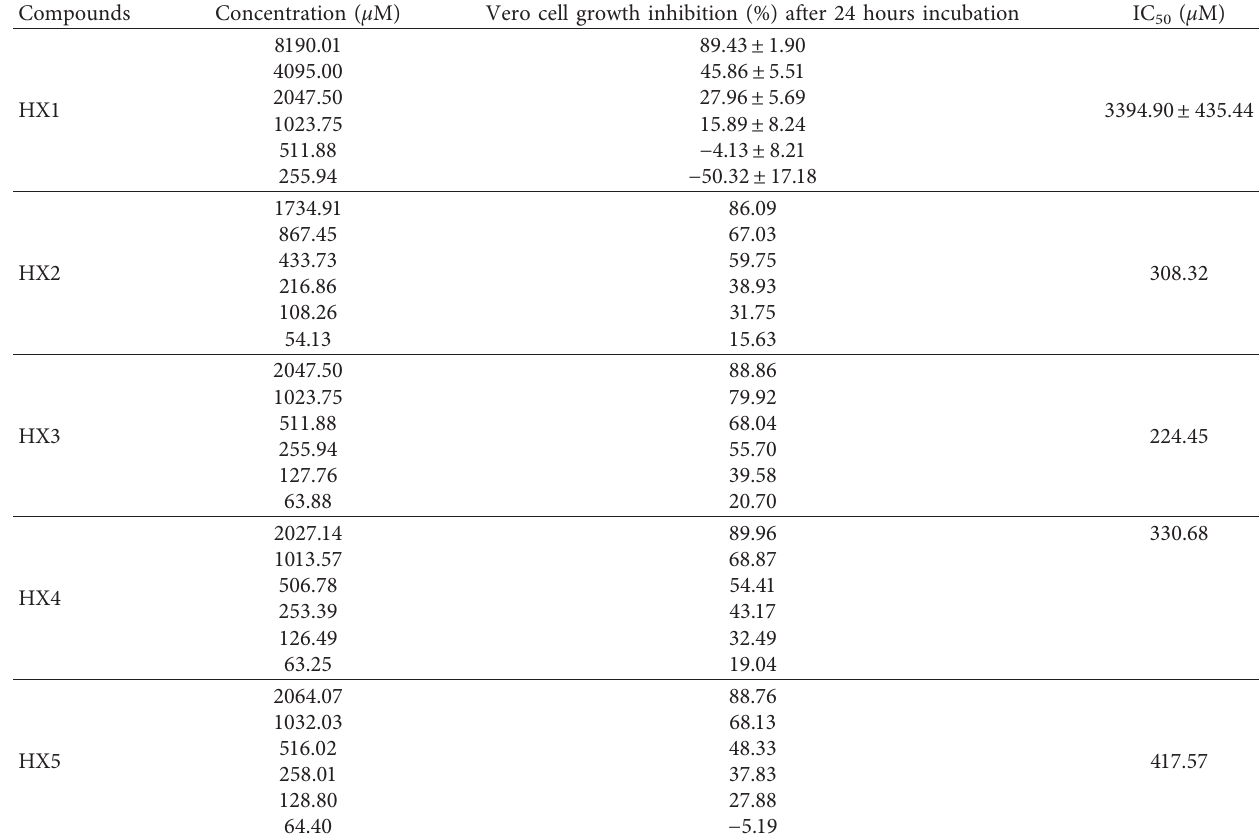
Table 4: The IC 50 values of hydroxyxanthone compounds on Vero cell after 24 hours incubation using the MTT assay method. Compounds